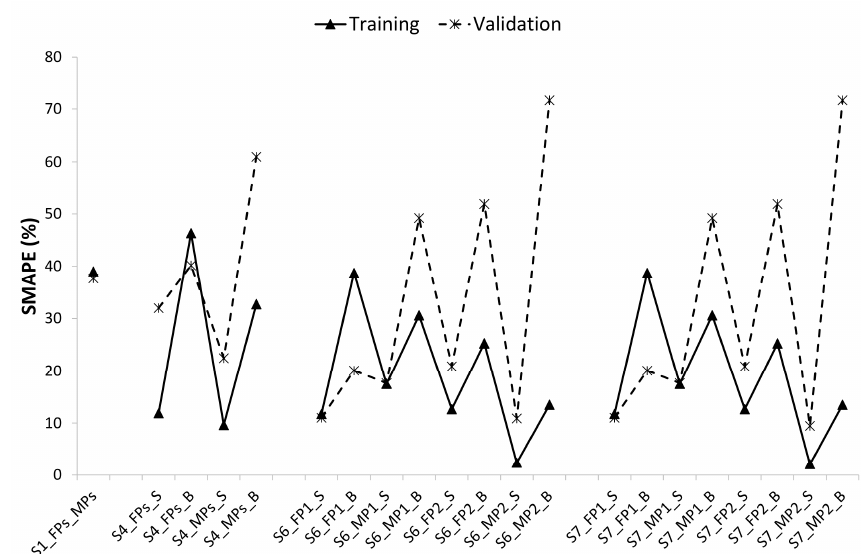
Figure 5. Symmetric mean absolute percentage error of the models with the best predictive performance in different data partitioning and cross-validation strategies. Among seven strategies, only four strategies (S1, S4, S6 and S7) resulted in high predictive performing models, which were pond and depth-specific. FP = Facultative pond; MP = Maturation pond; S = Surface; and B = Bottom.